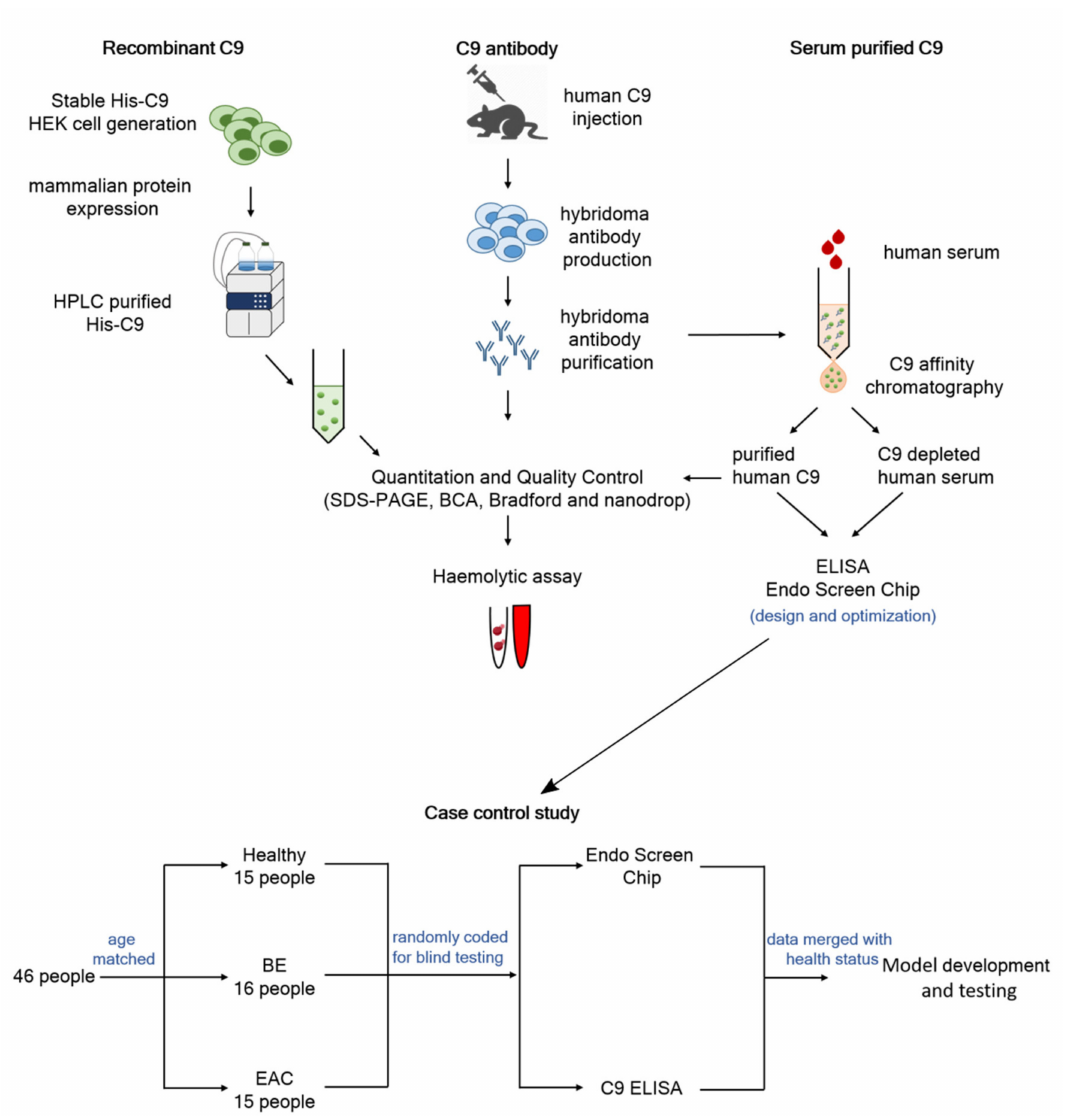
Figure 1. Study overview. High quality reagents including recombinant C9, C9 antibody and serum purified C9 were generated and used to develop C9 ELISA and EndoScreen Chip. The newly established assays were evaluated in a case- control cohort. Logistic regression was used to develop diagnostic algorithms for predicting BE or EAC, by combining blood markers with risk